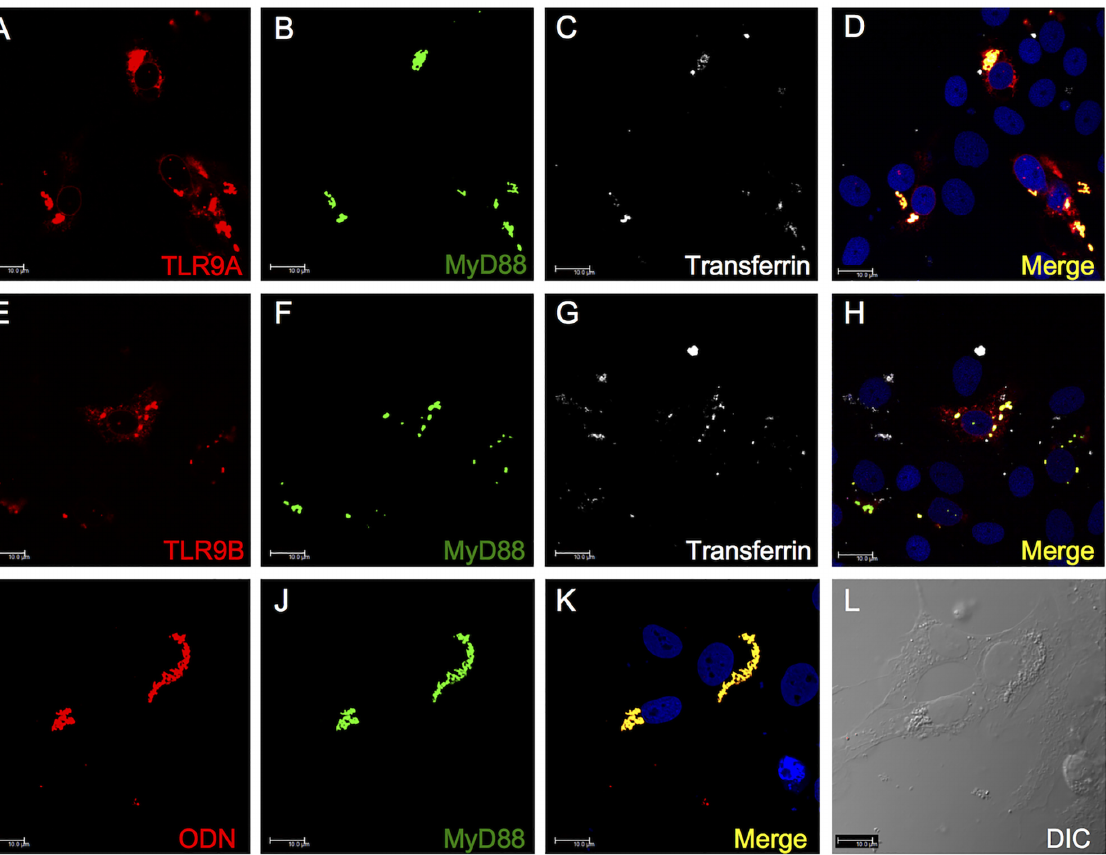
Fig 5. Sub-cellular co-localization of gTLR9A, gTLR9B, and gMyD88 in the endosome. GK cells were co-transfected with gTLR9A-Flag and YFP- gMyD88 ( A – D ) or gTLR9B-HA with YFP-gMyD88 ( E – H ). Transfected cells were incubated with the endosome marker transferrin conjugated to Alexa Fluor 633 along with CpG ODN for 30 min. Images were then acquired on an inverted confocal microscope. The merged images ( D & H ) demonstrate that gTLR9A and gTLR9B can translocate to the endosome and co-localize with gMyD88 upon stimulation with CpG ODN. The sub-cellular co-localization of CpG ODN and the receptor-adaptor complex was assayed in GK cells transfected with EYFP-MyD88 and treated with Texas-red-conjugated ODN. Both ODN ( I ) and gMyD88 ( J ) formed granular aggregates and co-localized with each other ( K ). The fluorescent granules exhibited structural features of organelles under differential interference contrast (DIC) microscopy ( L ). Scale bar: 10 μ m. Results present the observation of 100 transfected cells or more from one representative experiment out of